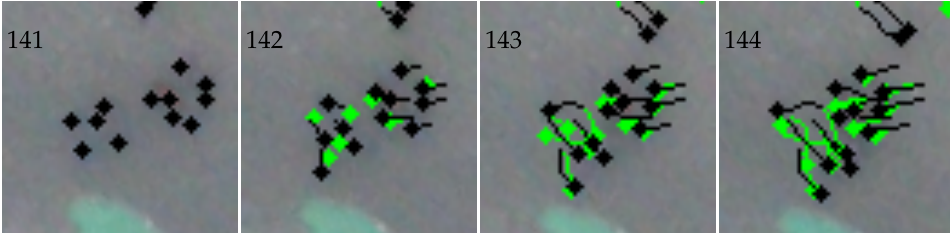
Figure 10. A failure case by Stacked-DCFNet on the test sequence “RaR_Snack_Zone_04”. The tracking results and the ground truth are depicted in green and black, respectively.